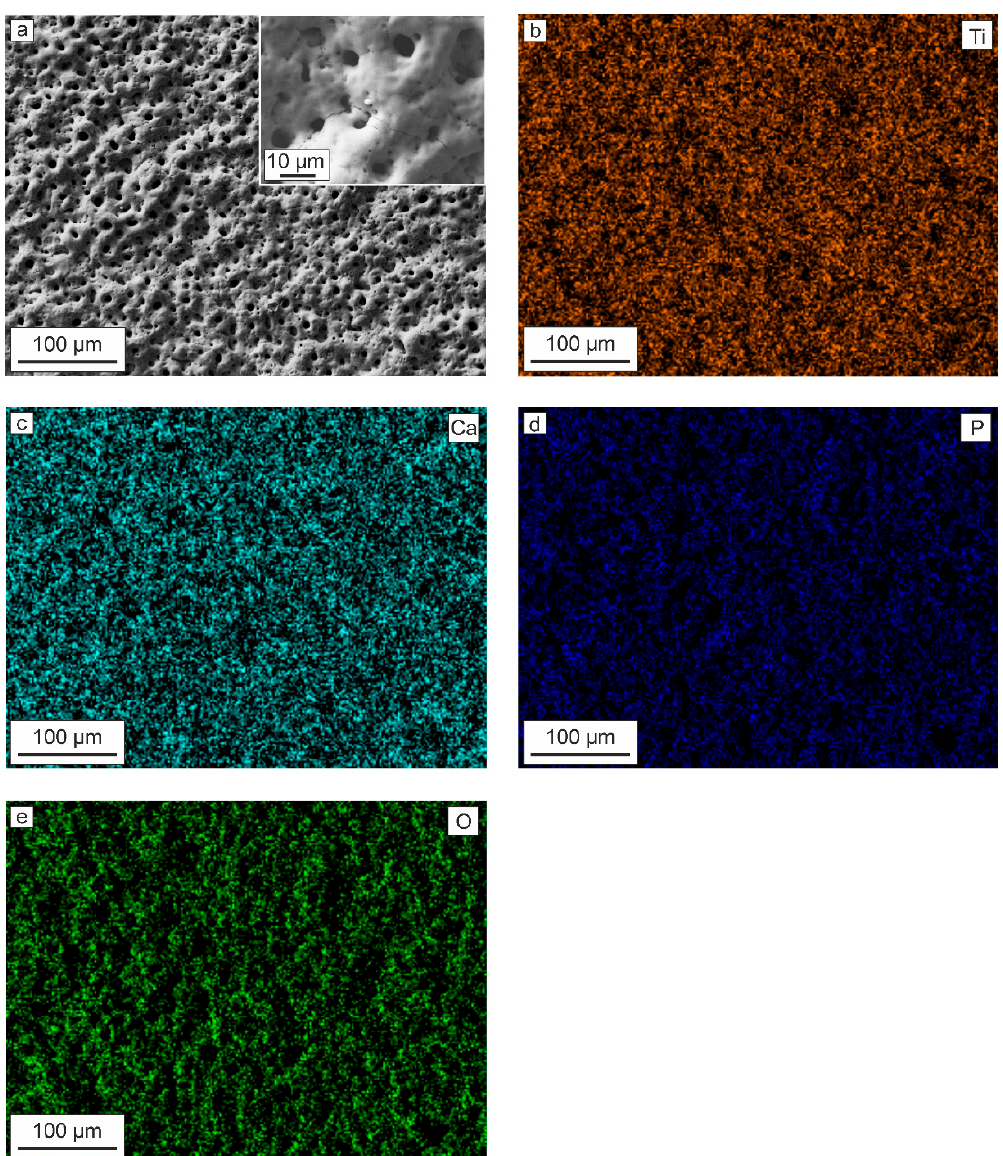
Figure 1. SEM-image of the ( a ) PEO-coating and a map of the elements distribution: ( b ) titanium, ( c ) calcium, ( d ) phosphorus, and ( e ) oxygen.